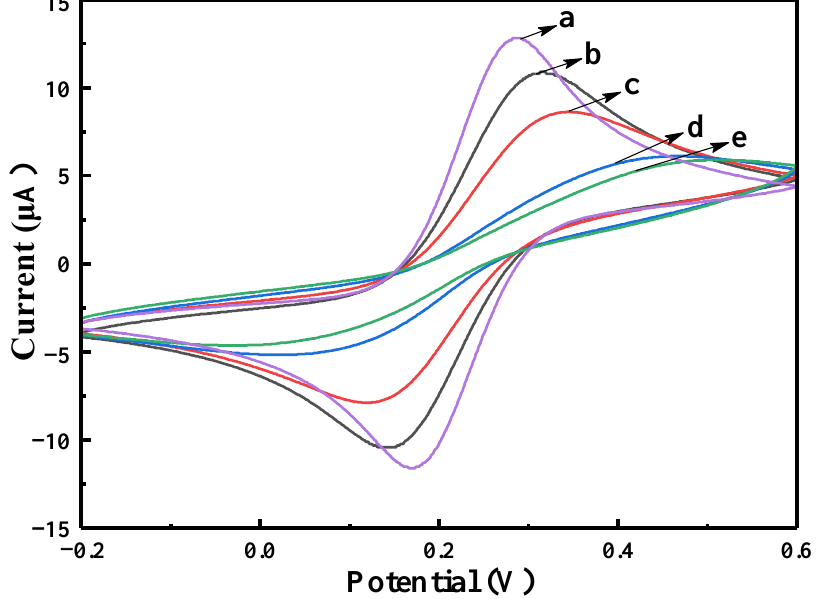
Figure 4. Cyclic voltammetric test diagram of modified electrodes in different states: ( a ) GCE, ( b ) GCE/Ru-AuWS 2 , ( c ) GCE/Ru-Au-WS 2 /Ab, ( d ) GCE/Ru-Au-WS 2 /Ab/BSA, ( e ) GCE/Ru-Au- WS 2 /Ab/BSA/CEA.